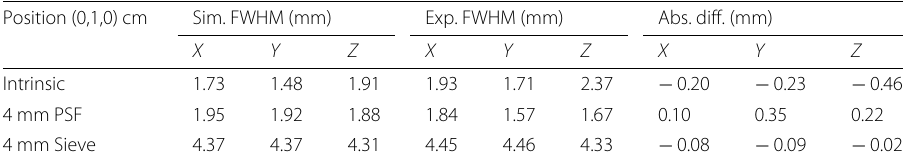
Table 5 Comparison of the intrinsic FWHM obtained before reconstruction for the (0,1,0) cm central position, with FWHM obtained after reconstruction Position (0,1,0) cm Sim. FWHM (mm) Exp. FWHM (mm) Abs. diff. (mm) X Y Z X Y Z X Y Z Intrinsic 1.73 1.48 4 mm PSF 1.95 4 mm